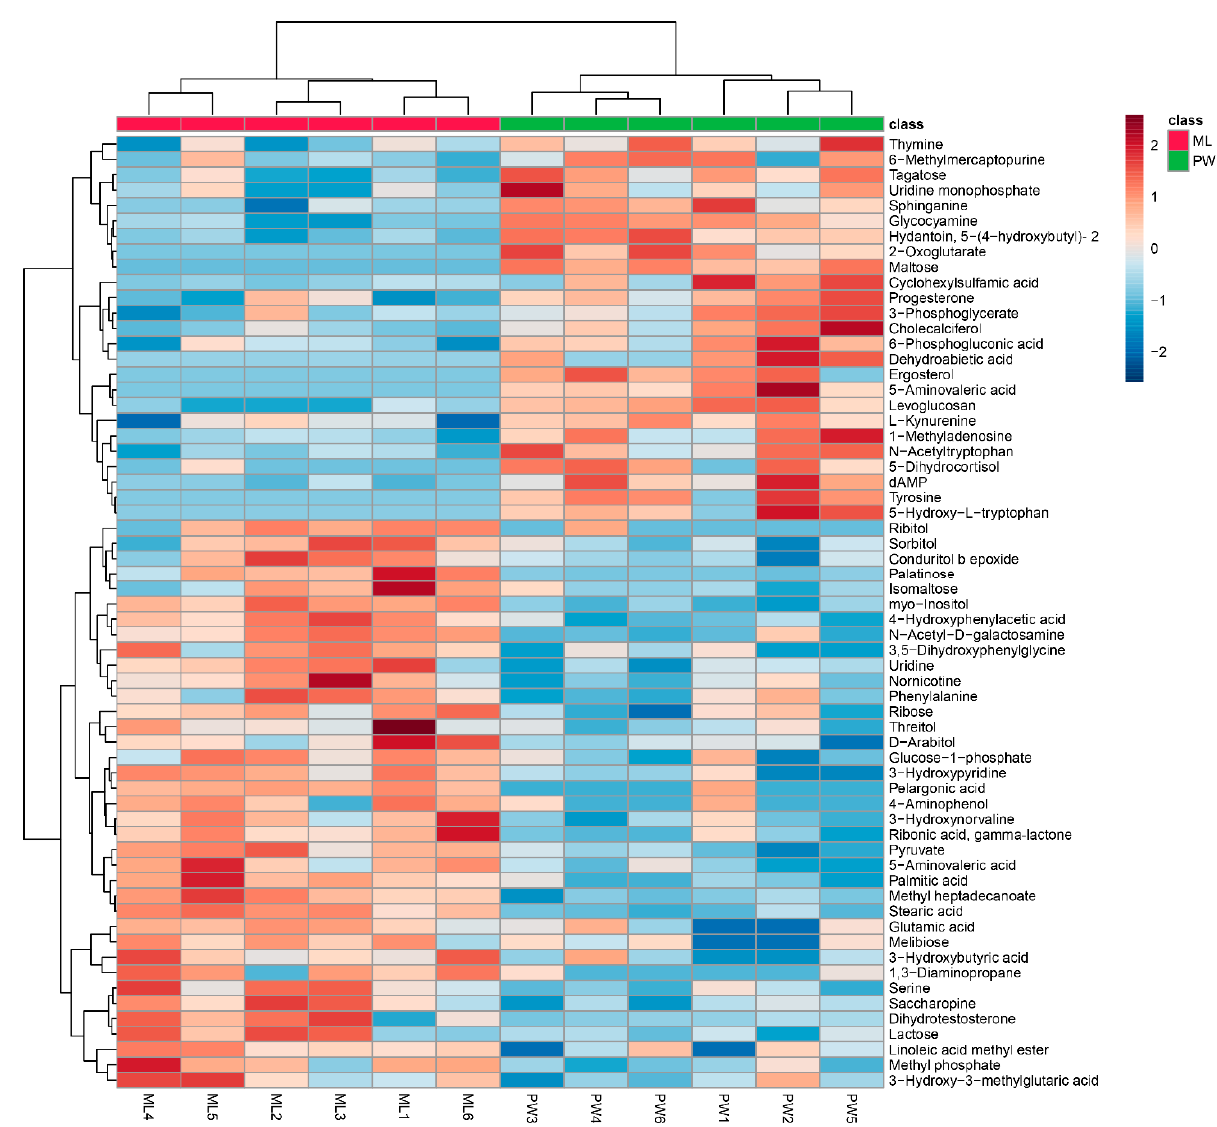
Figure 3. Hierarchical clustering analysis for significantly differentially abundant metabolites. The relative metabolite level is depicted according to the color scale. Red and blue indicate upregulated and downregulated metabolites in termites fed a M. micrantha leaves (ML) diet relative to those fed a pinewood (PW) diet,